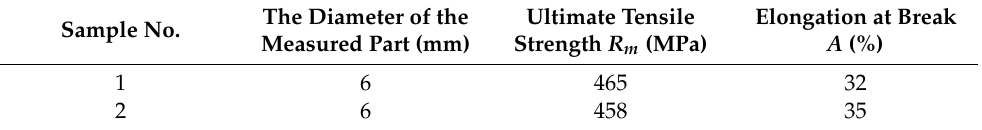
Table 4. Results of the static tensile tests of samples from the handy-size bulk carrier 30206 DWT. The Diameter of the Sample No. Measured Part (mm)